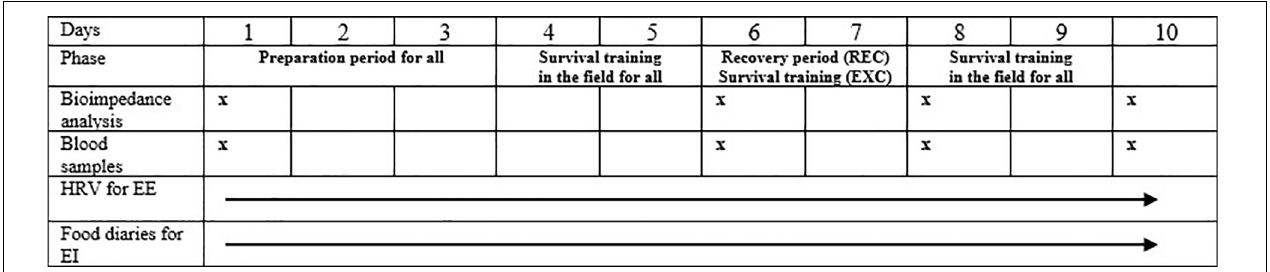
FIGURE 1 | Study protocol. The REC group had 2 days recovery period, whereas the EXC group was in the field all the training. HRV, heart rate variability; EE, estimated energy expenditure, EI, energy intake.